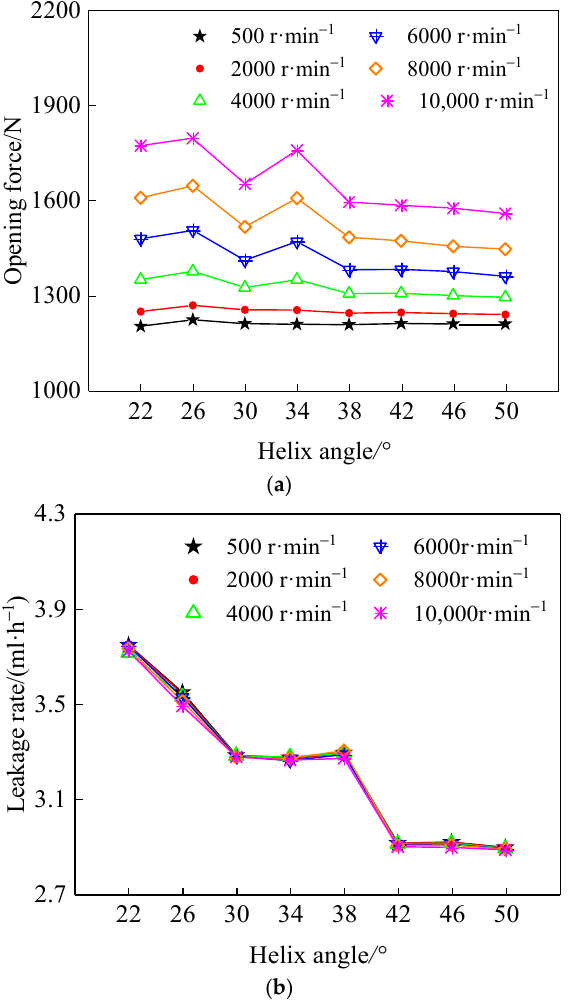
Figure 14. Influence of the helix angle on the sealing performance: ( a ) Influence on the opening force; ( b ) Influence on the leakage rate. ( r k = 34 mm, h ki = h g = 50 μ m, r o = 30.6 mm, γ = 0.5, N g = 22, λ = 0.9, Δ p = 0.5 MPa).